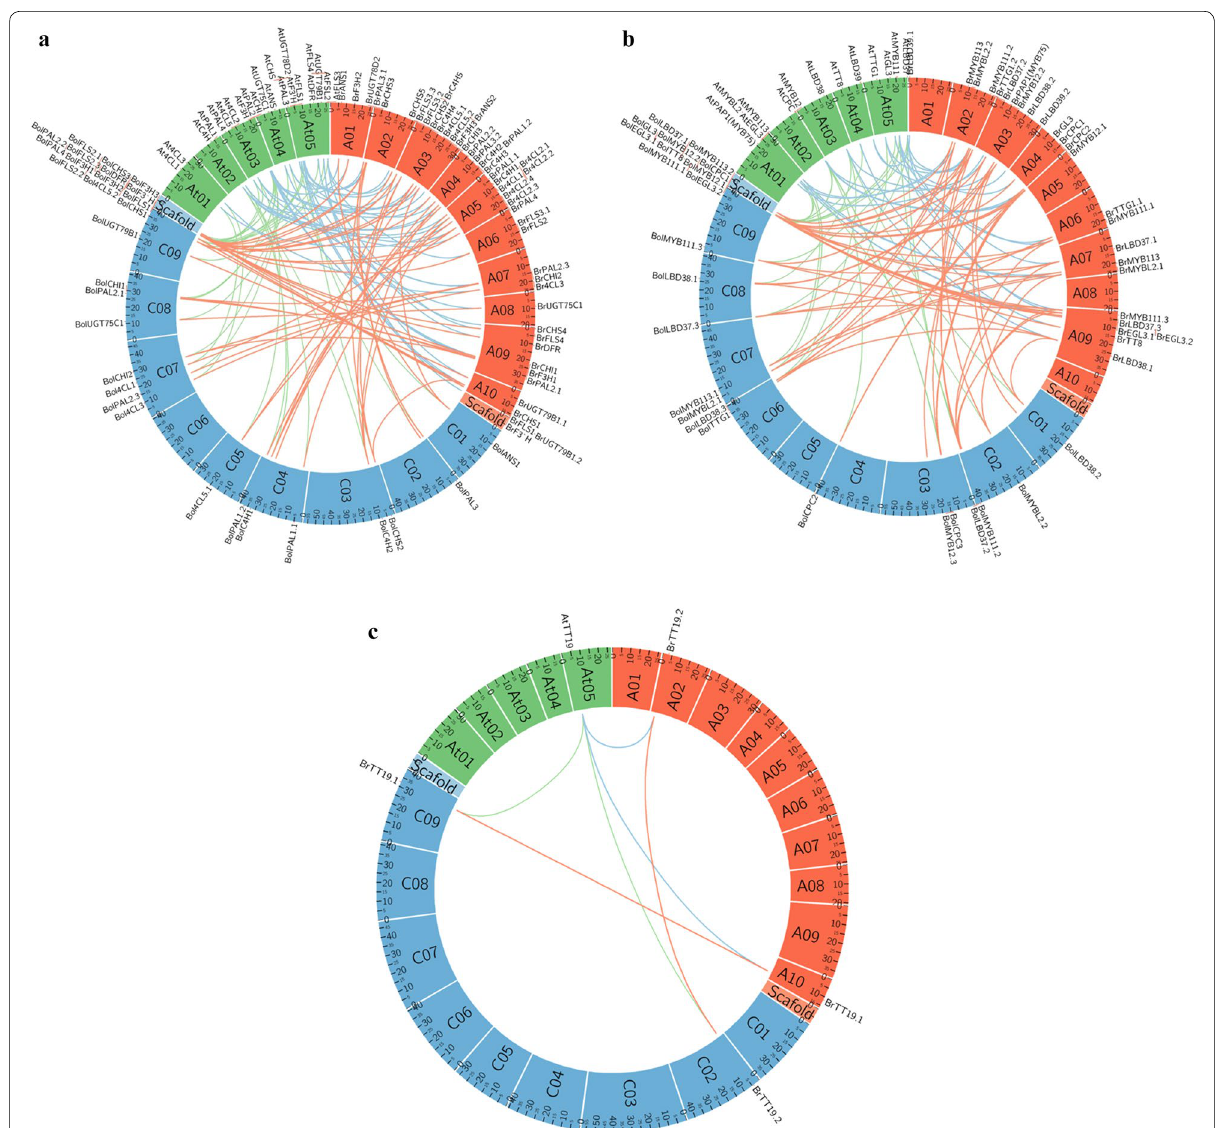
Fig. 3 Microsyntenic analyses of anthocyanin biosynthesis pathway genes. a Structural, early‑biosynthesis, and late‑biosynthesis genes, b positive‑ and negative‑regulatory genes, and c transporter genes in Arabidopsis thaliana (At, green), Brassica rapa (A, orange), and B. oleracea (C,